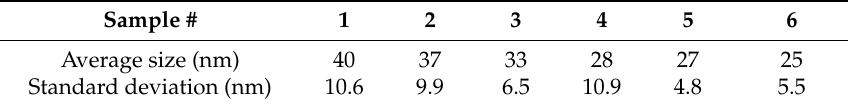
Table 2. Average particle size with different conditions.